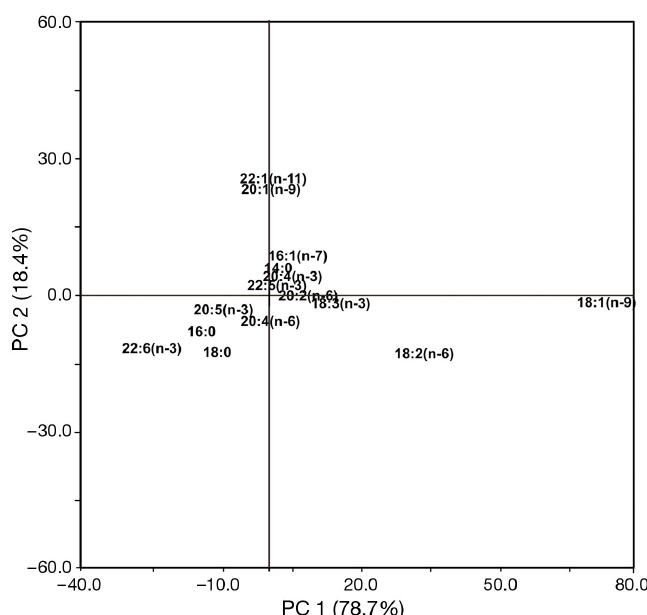
Fig. 6. Salmo salar . Loading plot of principal component (PC) analysis of fatty acids in total lipids and triacylglycerols in the adipose fin of farmed and wild salmon (see score plot in Fig. 5). Fatty acids closer to the origin are not